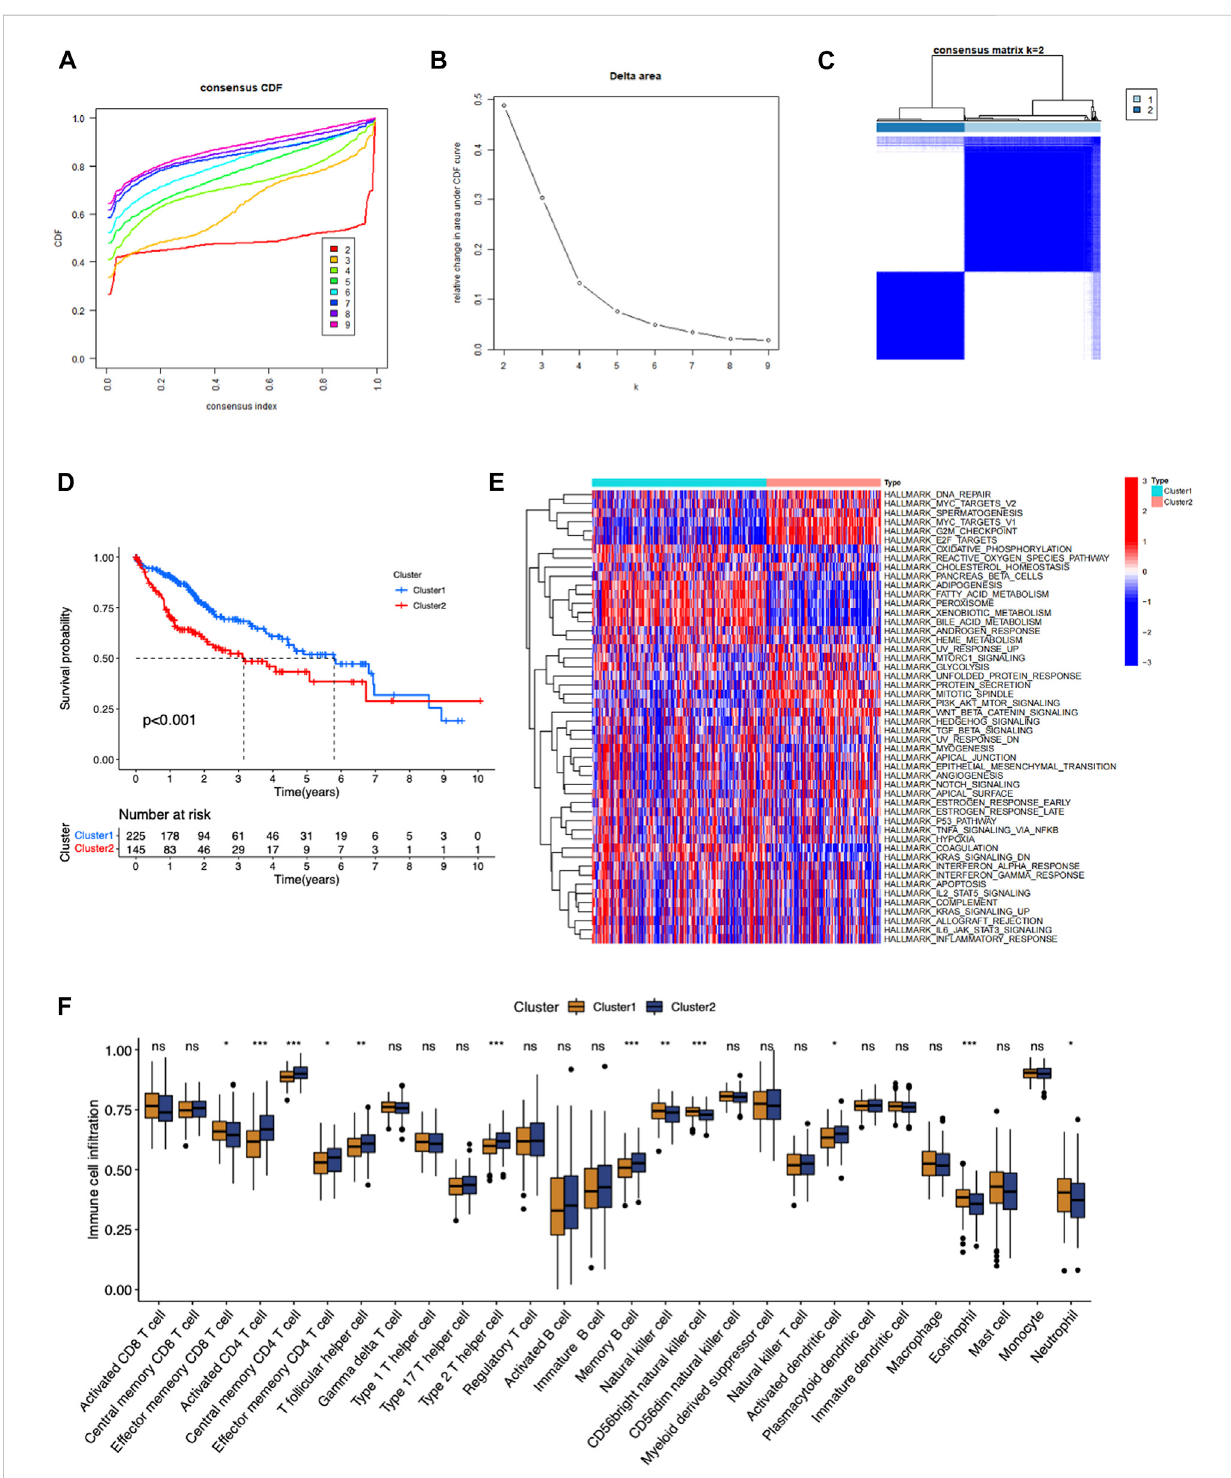
FIGURE 2 Identi fi cationofconsensusclustersbyeighttypesofRNAmodi fi cationregulatorsinLIHC. (A) Cumulativedistributionfunction(CDF)for k =2 – 9. (B) The area under the CDF curve k = 2 – 9. (C) Consensus clustering matrix for k = 2. (D) Kaplan – Meier survival curve of two clusters. (E) The heatmap of the different cancer hallmarks enriched in two clusters. (F) The difference of the immune cells in fi ltrated in tumor microenvironments between two